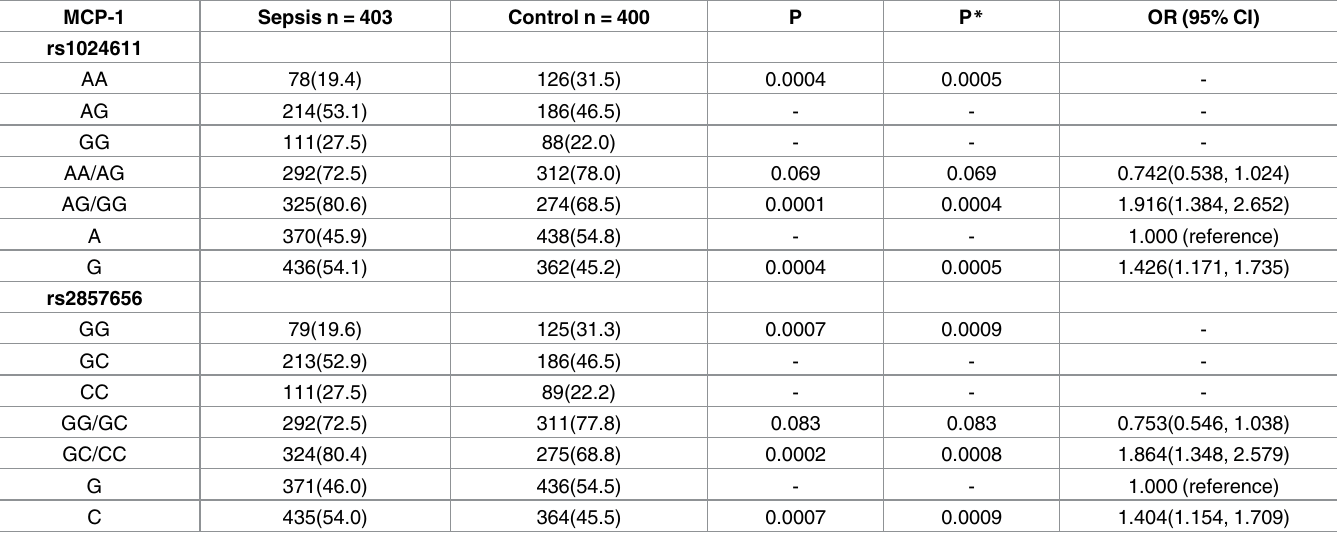
Table 2. Frequencies of the MCP-1 genotypes and alleles in the sepsis patients and